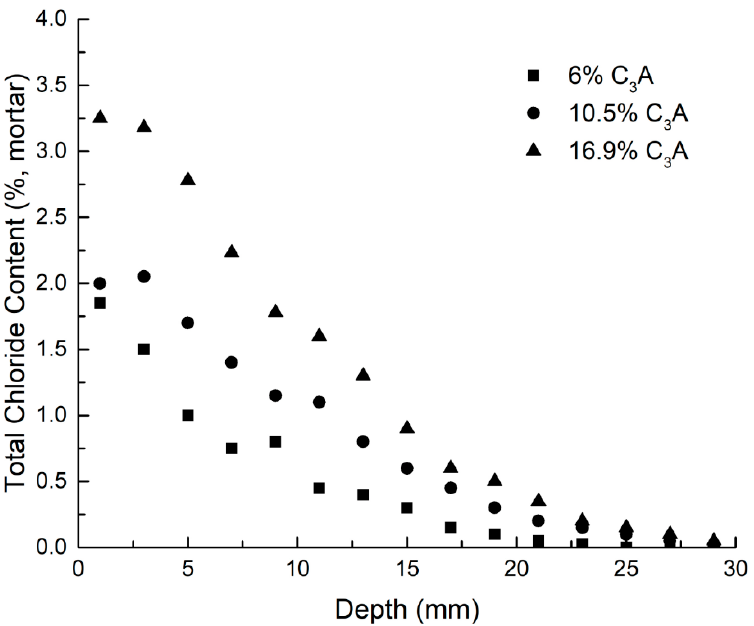
Figure 1. Chloride profiles for mortar samples with different C 3 A contents after exposure to a 4.0 M NaCl solution for 100 days [49].